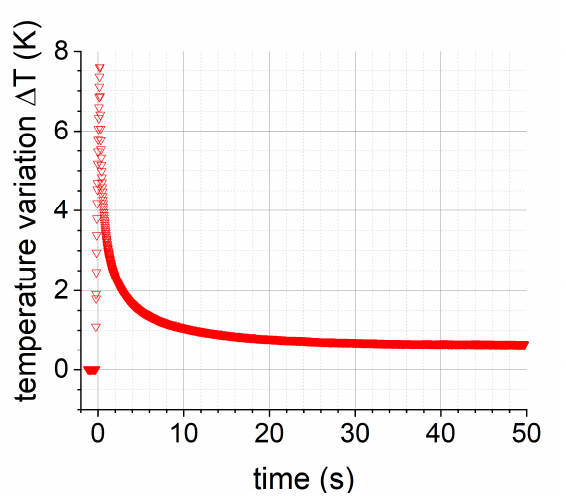
Figure 10. Averaged surface temperature transient recorded for the type 1 sample during and after the 0.5 s laser pulse (averaged over the white dashed rectangle in Figure 8).